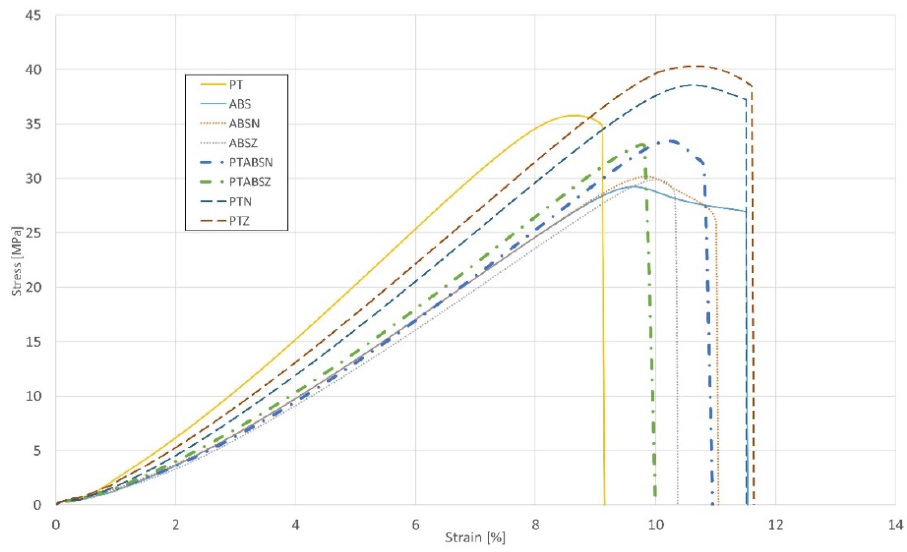
Figure 11. Comparison of stress-strain curves for all types of specimens tested.